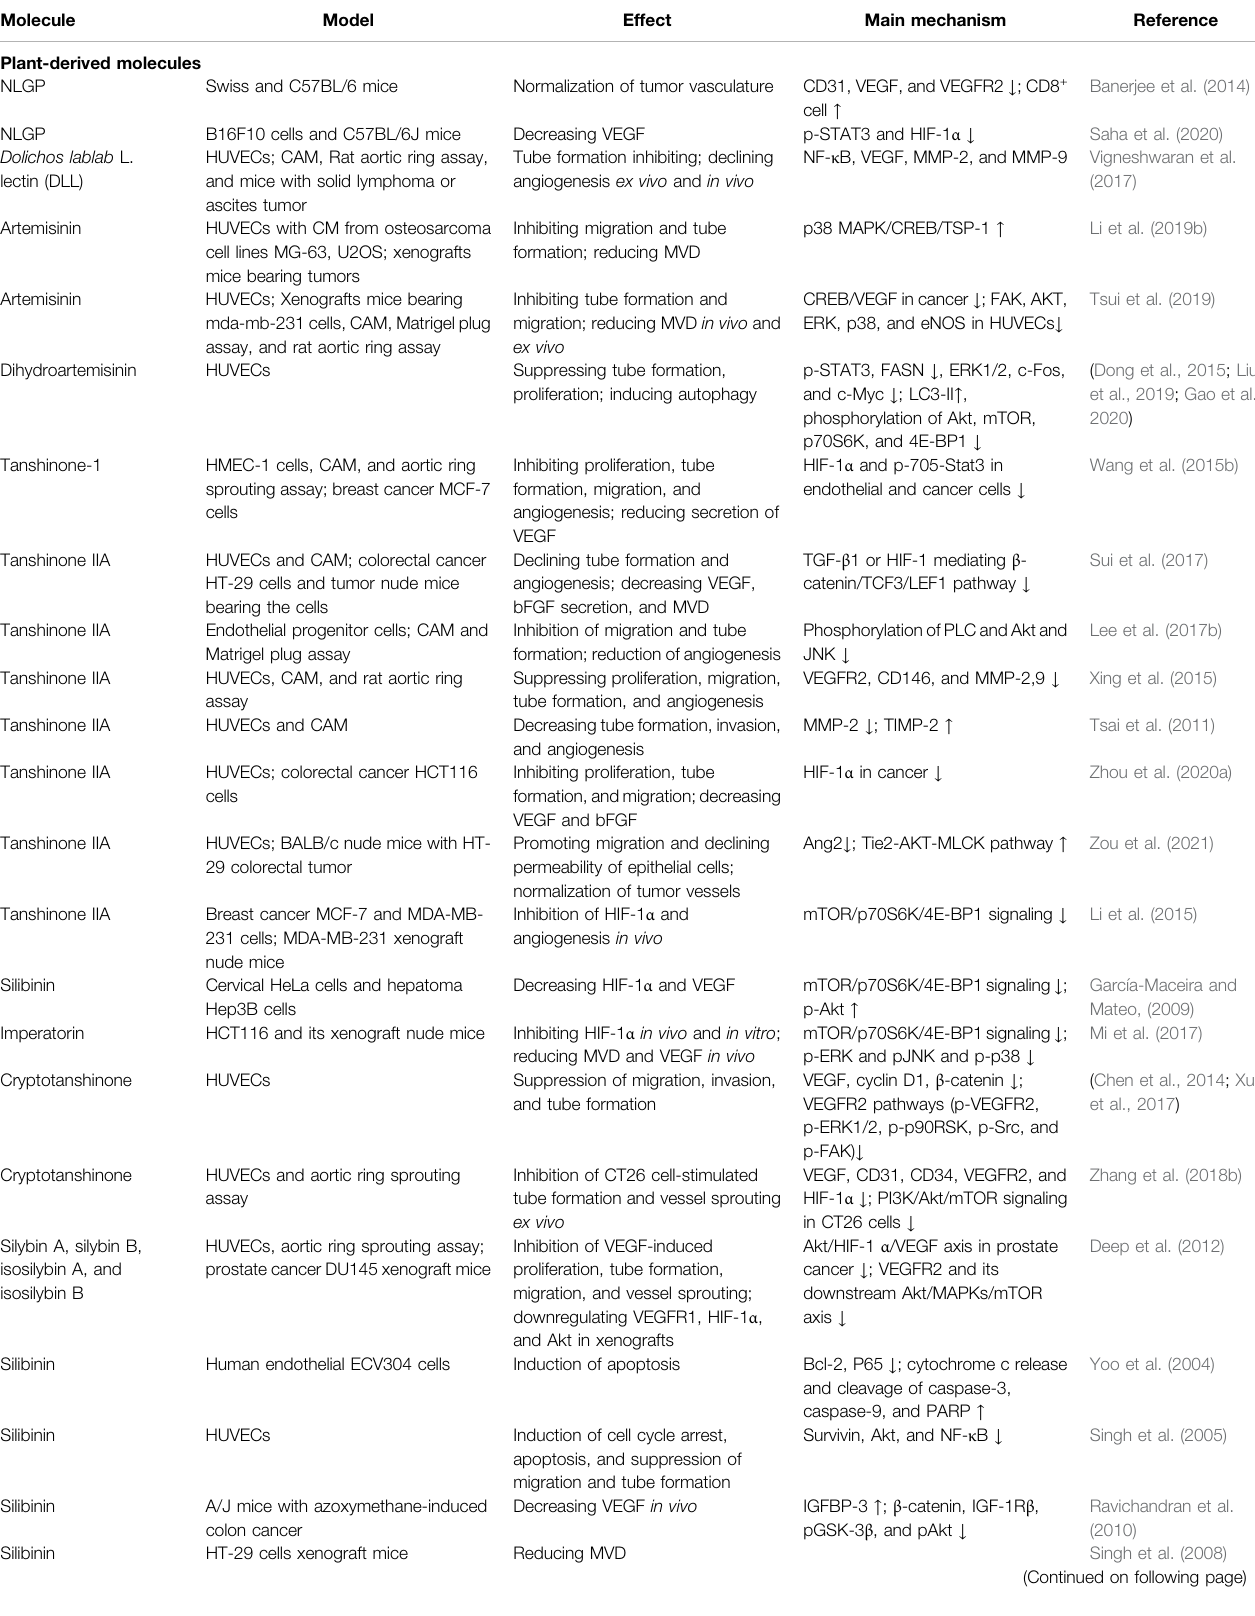
TABLE 1 | Anti-angiogenic effects and mechanisms of representative molecules from